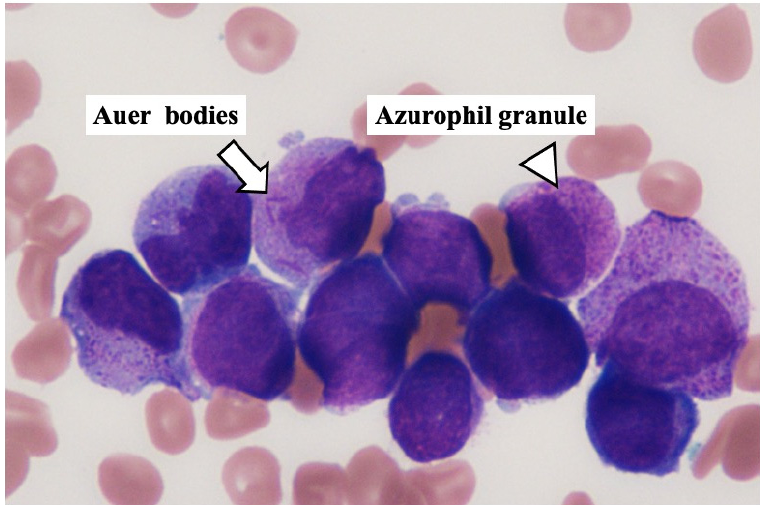
Figure 2. Leukemia cells in the peripheral blood obtained from this hospitalized patient. The pe- ripheral blood smear shows a possible presence of myeloid leukemia cells with Auer rods (arrow) and azurophilic granules (arrowhead).